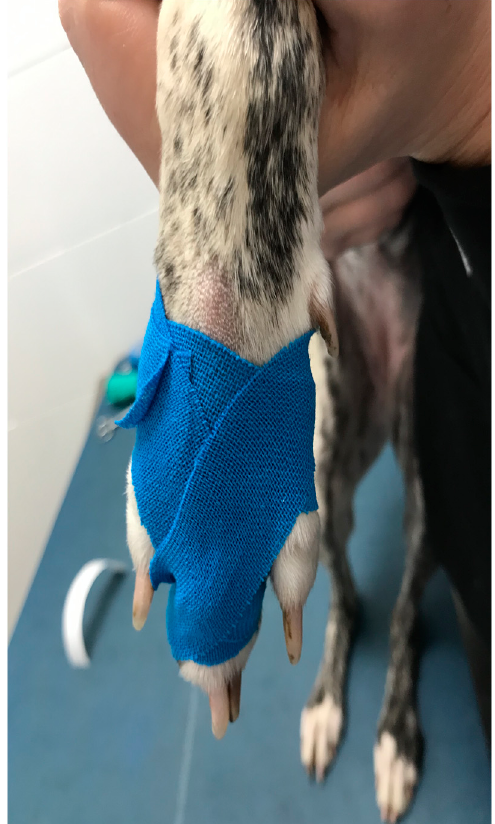
Figure 5. Case 1. Application of the buddy taping technique to patient number 1. The tape is applied fixing the involved digit to the adjacent one in order to take advantage of the splinting action offered by the adjacent intact digit. ROM is only partially limited. by the adjacent intact digit. ROM is only partially